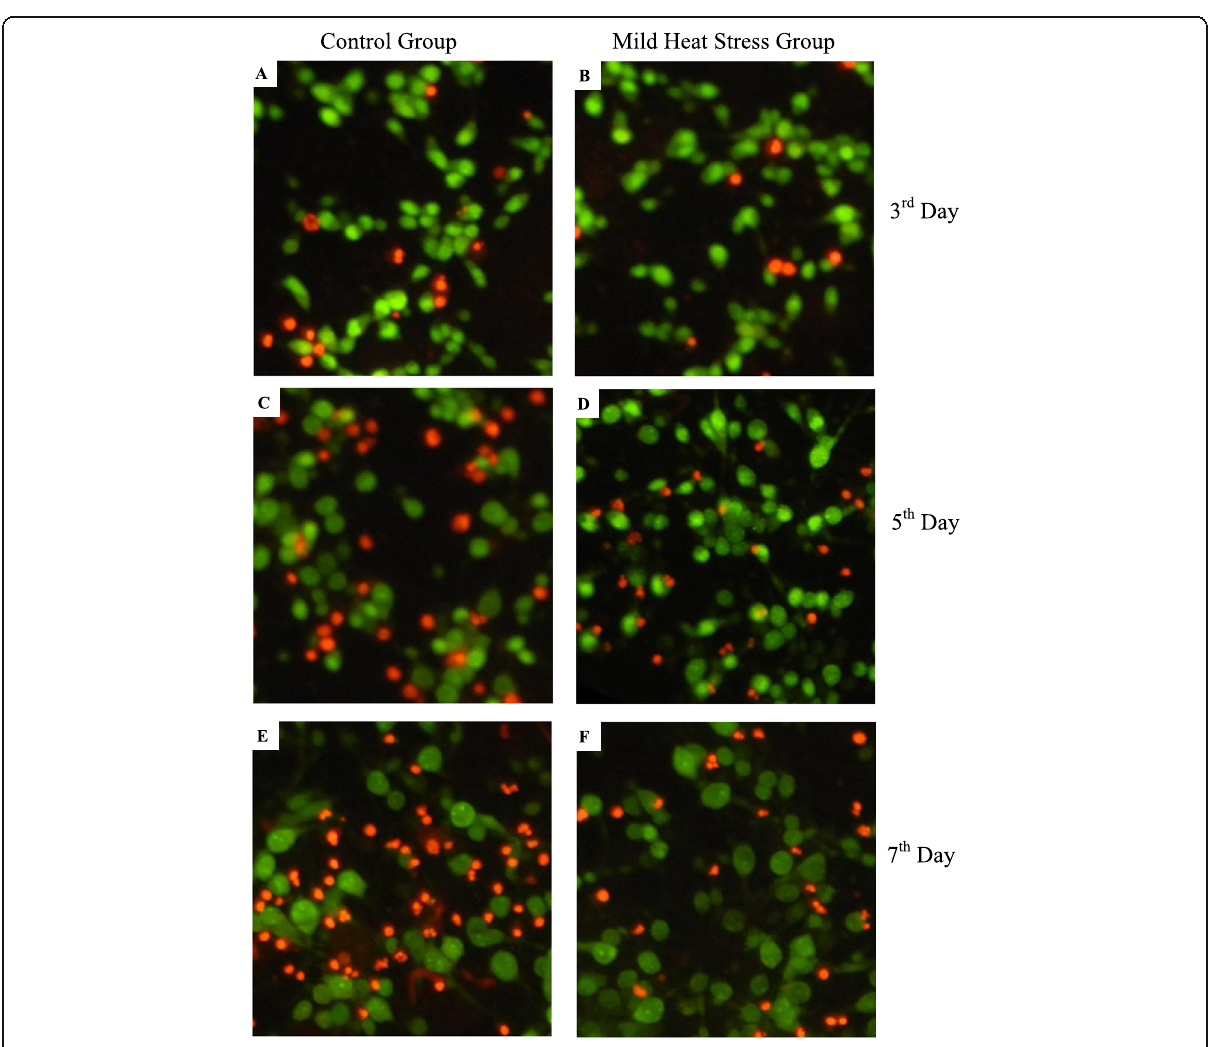
Fig. 1 Fluorescence micrograph of the primary cultured mouse prefrontal cerebrocortical neurons stained by Calcein-AM and propidium iodide. Green fluorescence indicates functional esterase activity in the live cells, and orange fluorescence indicates the staining of nuclei in dead cells by propidium iodide. Note that a higher number of viable neurons (green fluorescence) in the mild heat stress group and a greater number of dead neurons (orange fluorescence) in the control